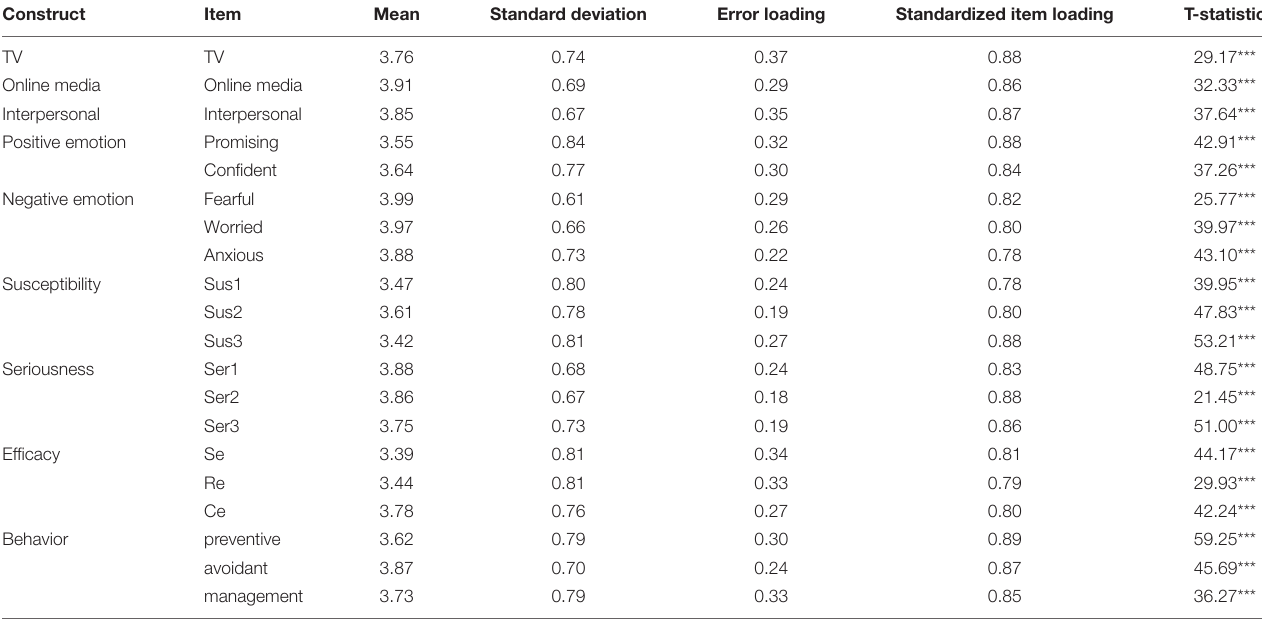
TABLE 1 | Scale properties of structure model.